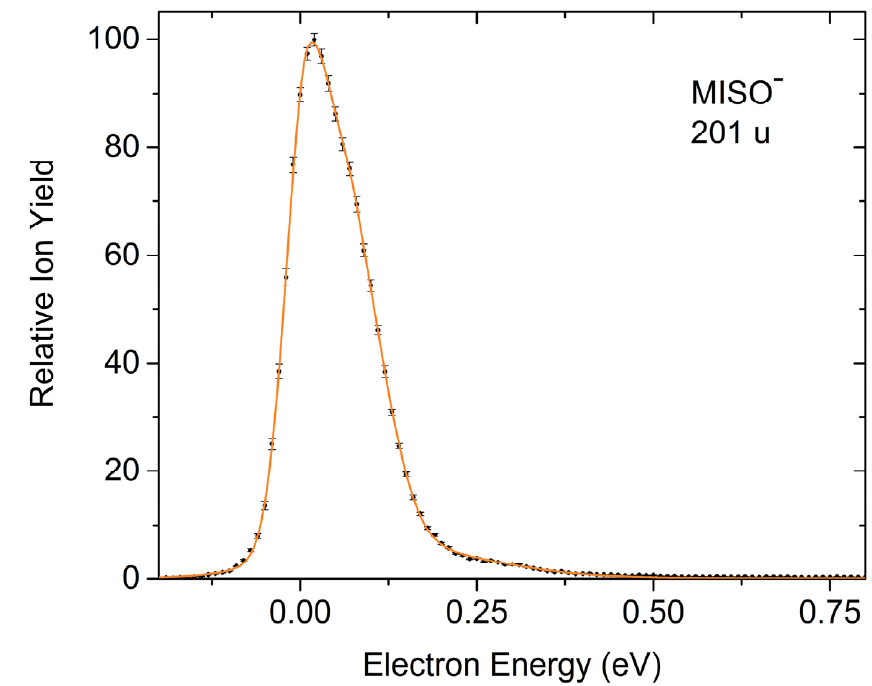
Figure 2. Relative ion yield for the associative attachment (AA) process generating the non-decomposed molecular anion.